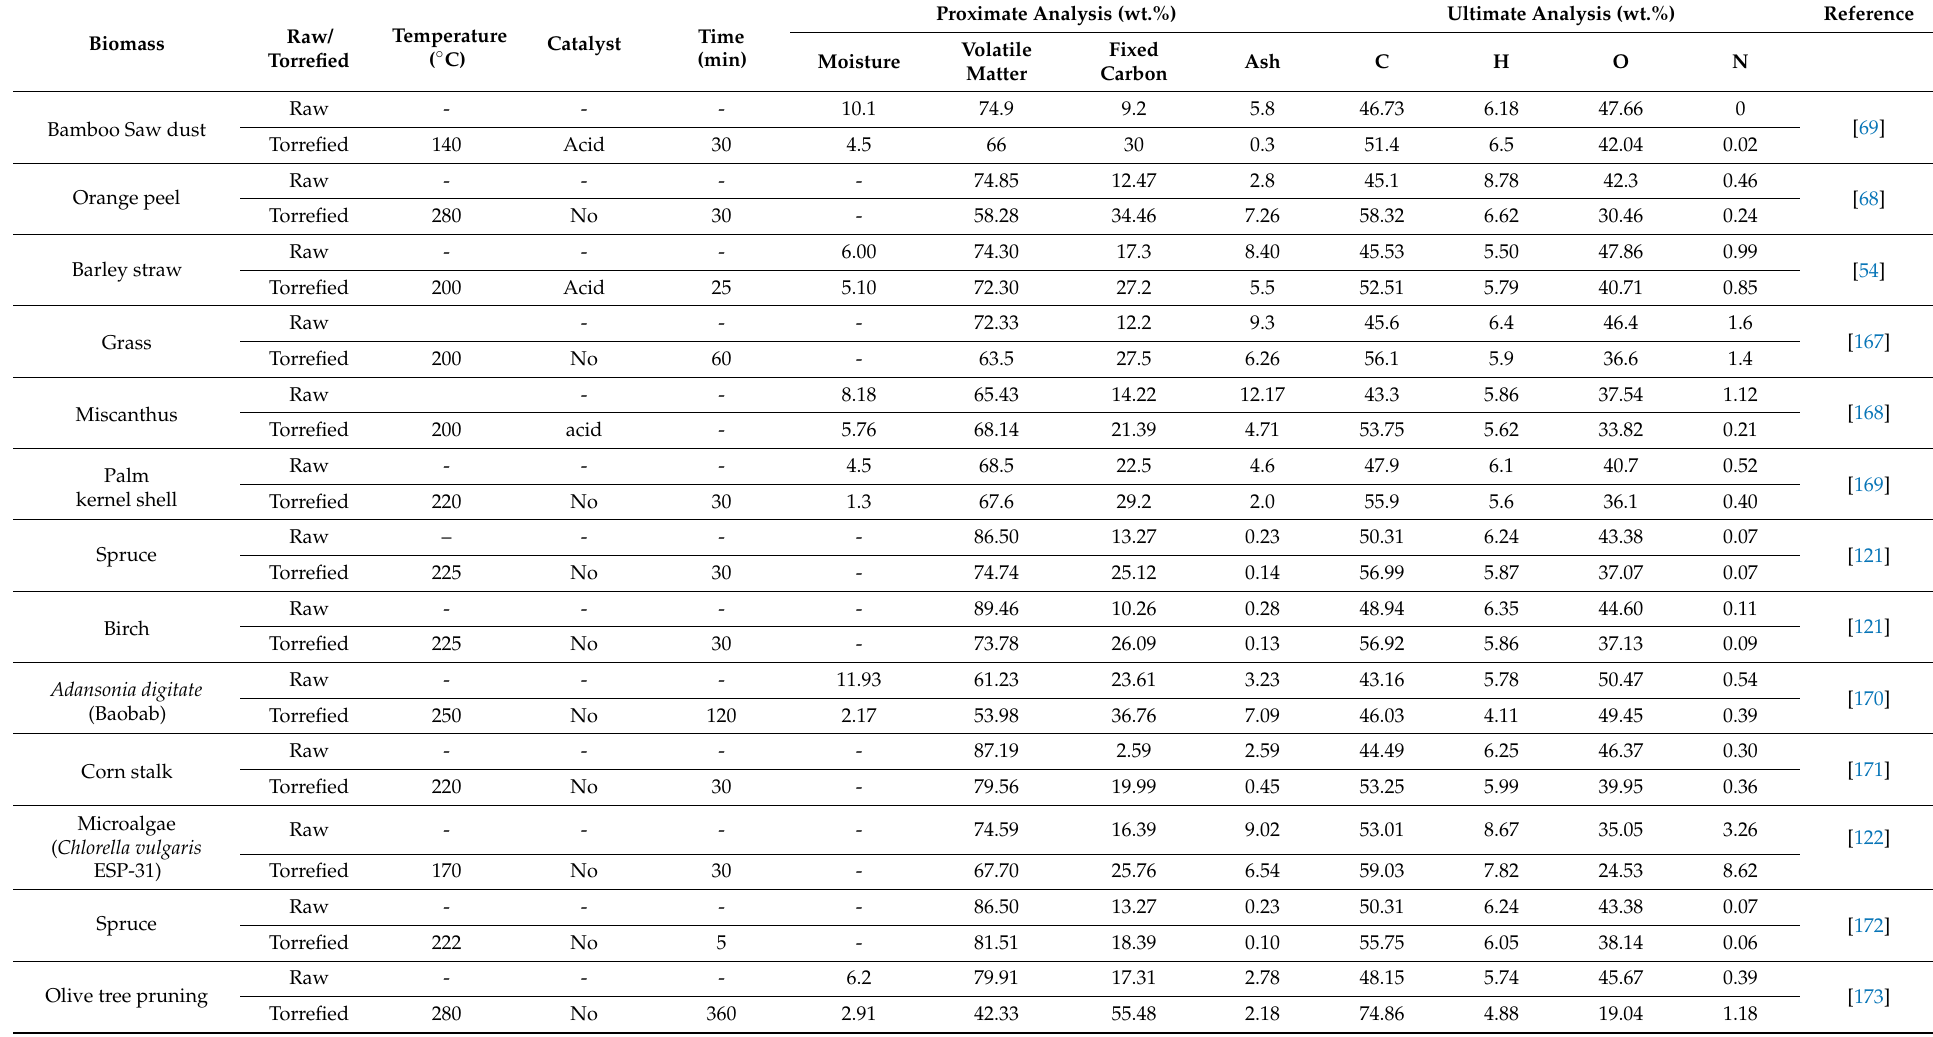
Table 4. The wet torrefaction effect on the proximate and ultimate compositions of lignocellulosic